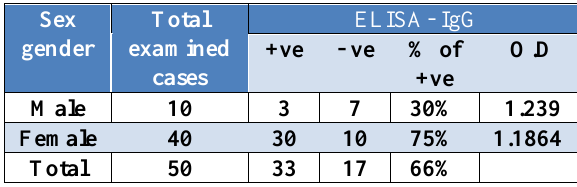
Table, 1: Seropositive ELISA- IgG in cats according to the